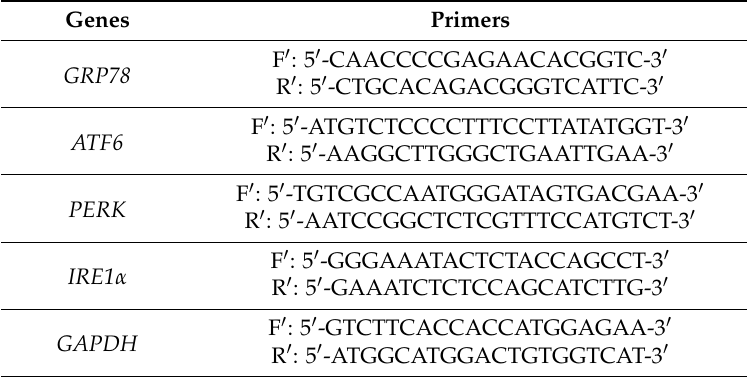
Table 1. Primers designed for real-time PCR in this